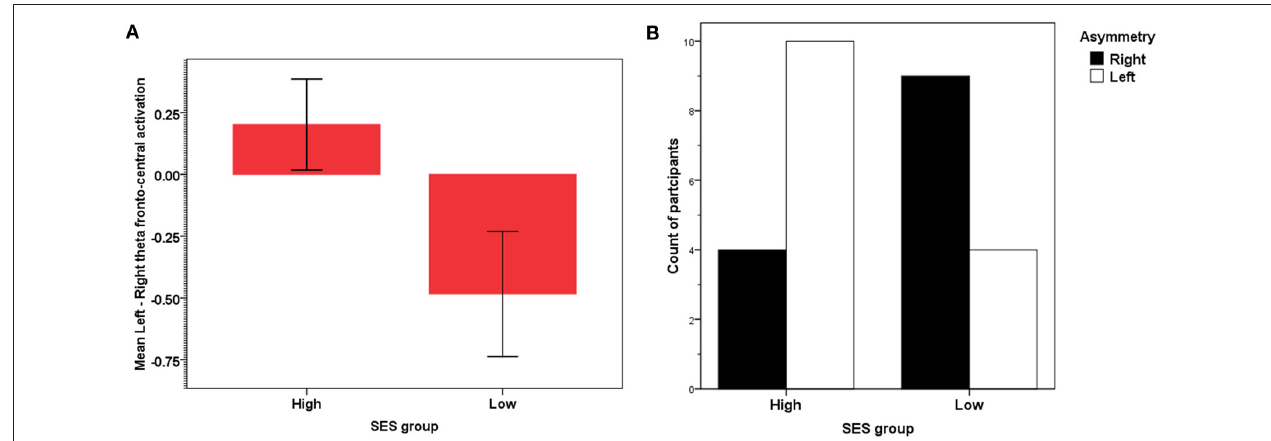
FIGURE 5 | (A) Frontal asymmetry in theta activation in high- and low-SES children. (B) Relative frequency distribution of right vs. left frontal theta asymmetry in high- and low-SES children.